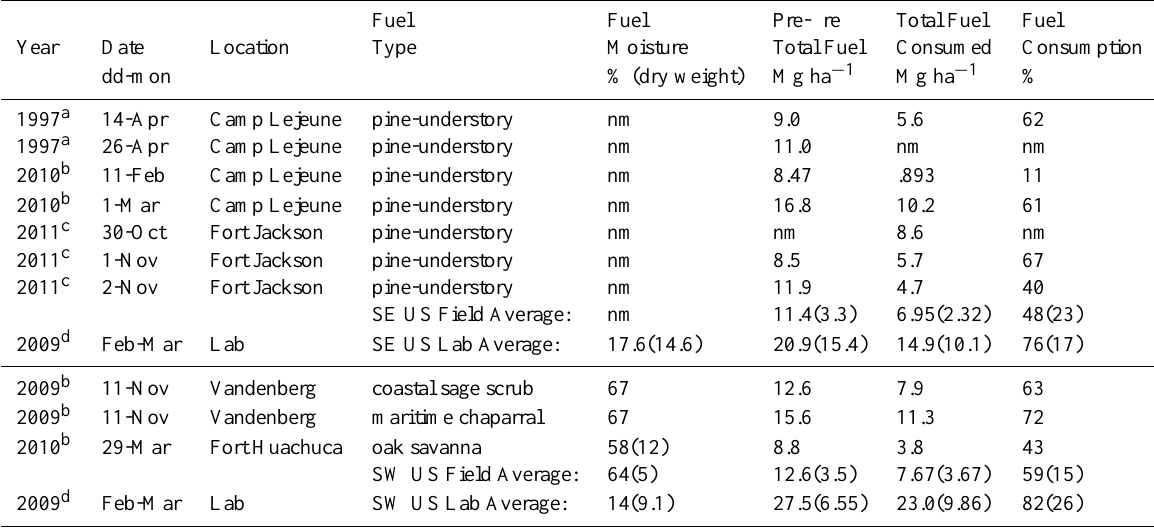
Table 5. Prescribed fire fuel consumption measurements from 1997, 2010, and 2011 for southeastern (SE) US and 2009–2010 for southwest- ern (SW)